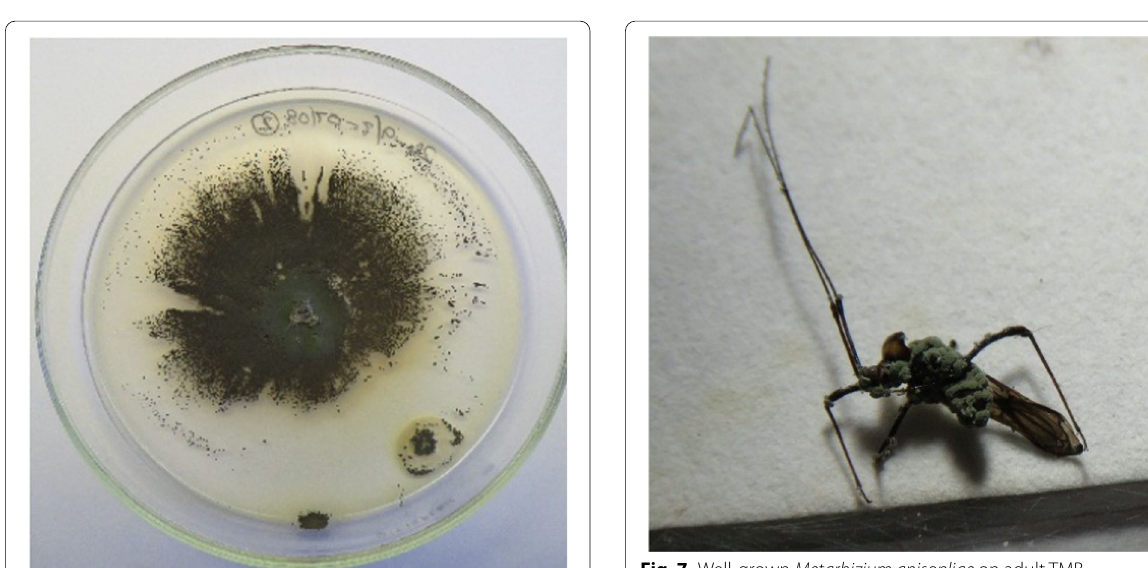
Fig. 5 Metarhizium anisopliae isolated from soil